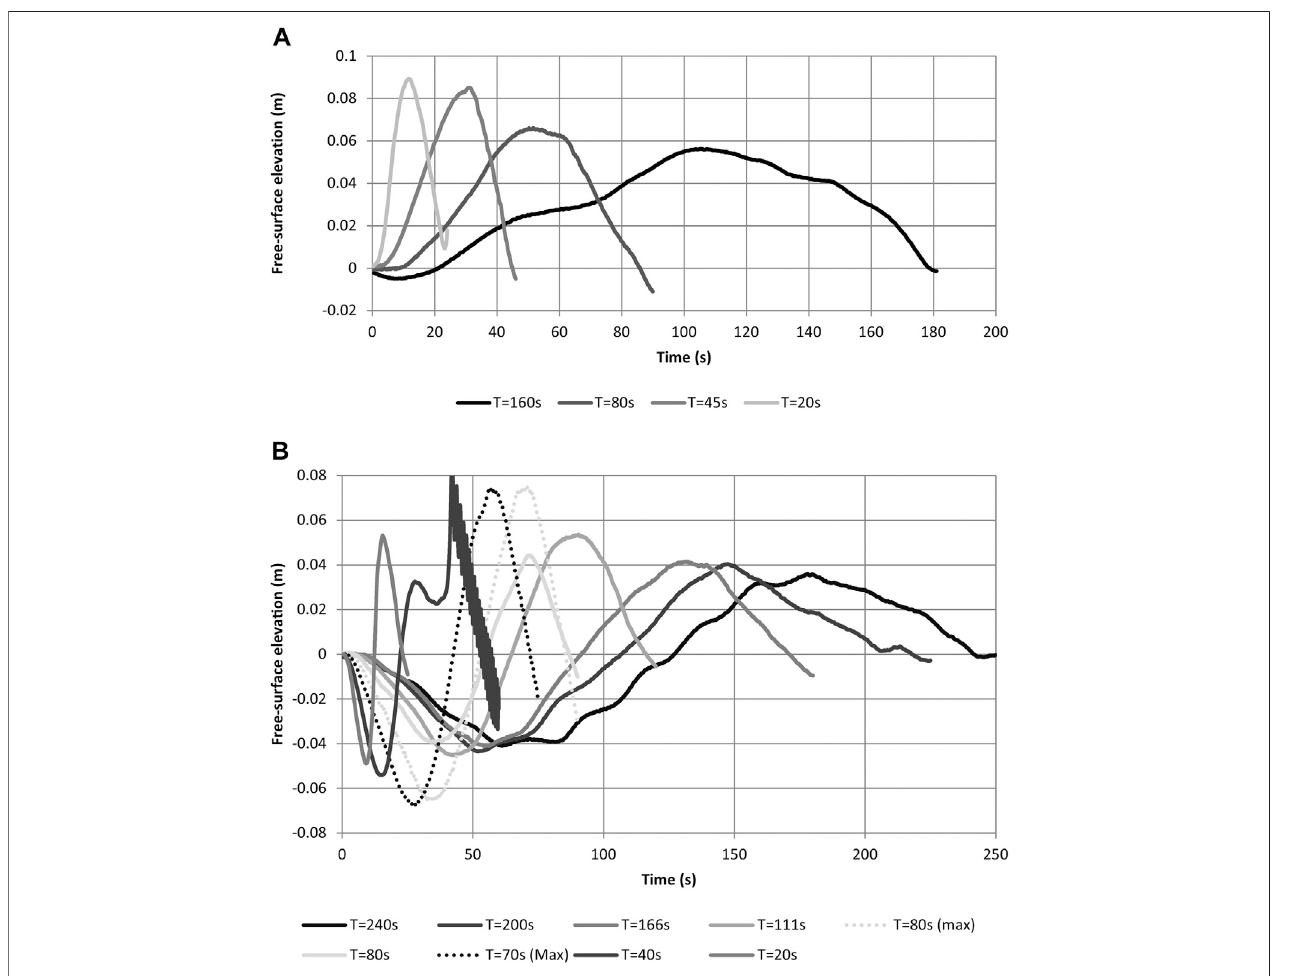
FIGURE 6 | Calibrated crest only (elevated) waves (A) and N-waves (B) using the second generation TS, measured at the toe of the bathymetry.